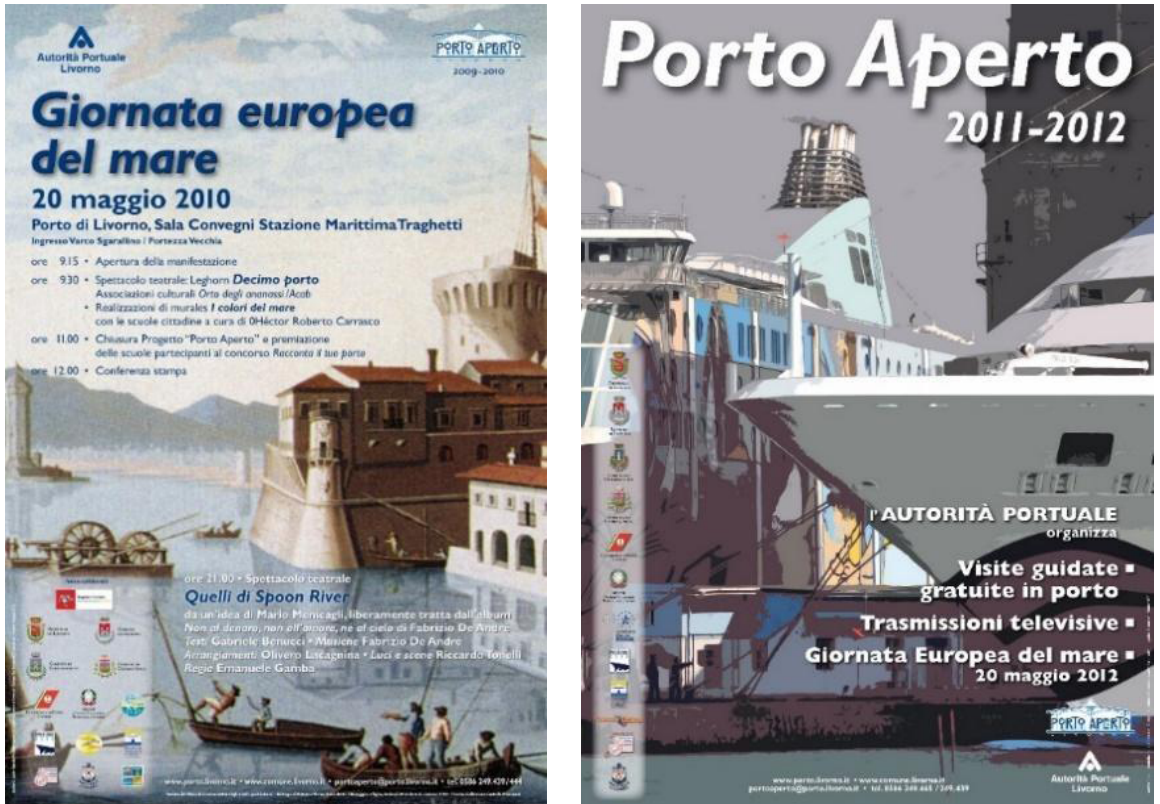
FIG. 4 Two “Open Port” Poster Programmes - (Graphic material produced by the North Tyrrhenian Port Network